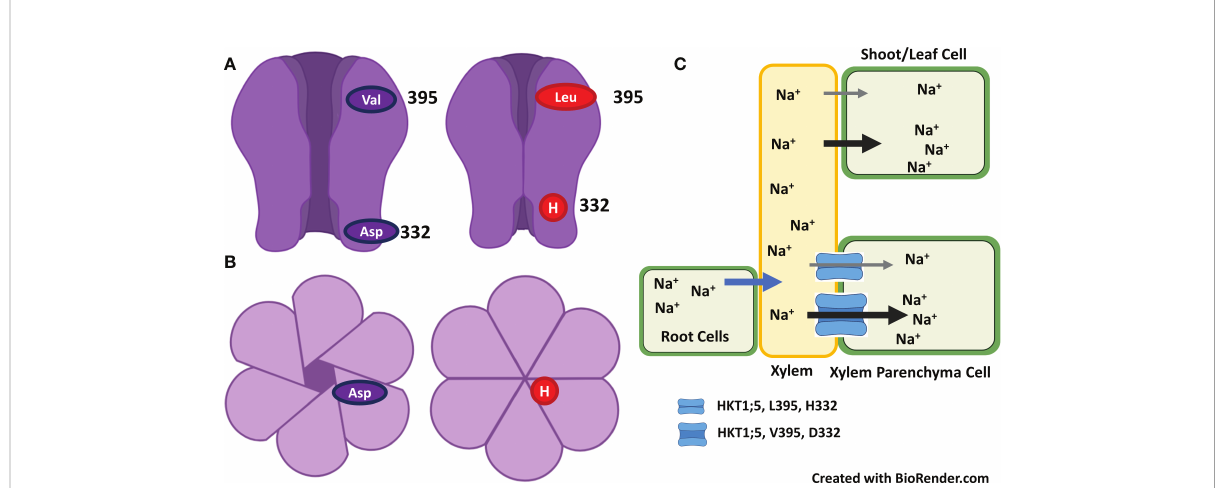
FIGURE 5 Na + and/K + selectivity for transport through HKT channel is determined by selective pores and aspartate at 332 and valine at 395 position which lie on the opening ends of channel but at the opposite sides. (A) Replacement of aspartate with histidine at position 332 that lies at the constriction of channel opening make Na + passage dif fi cult for entry – inhibit the Na + exclusion. (B) . Surface view of HKT channel as open or closed for Na + entry. (C) . Saline growth medium favors the entry of Na + into root and then transport Na + to leaves/shoots via xylem. HKT channel restrict the Na + transport from root to shoot by excluding Na + from xylem vessel to xylem parenchyma cells. Presence of valine at 395 and aspartate at 332 enhance the Na + exclusion from xylem to xylem-parenchyma and thus induces salt tolerance, whereas presence of leucine at 395 and histidine at 332 reduce the Na + exclusion and thus induces salt sensitivity (Adapted from Shohan et al., 2019; Pulipati et al.,